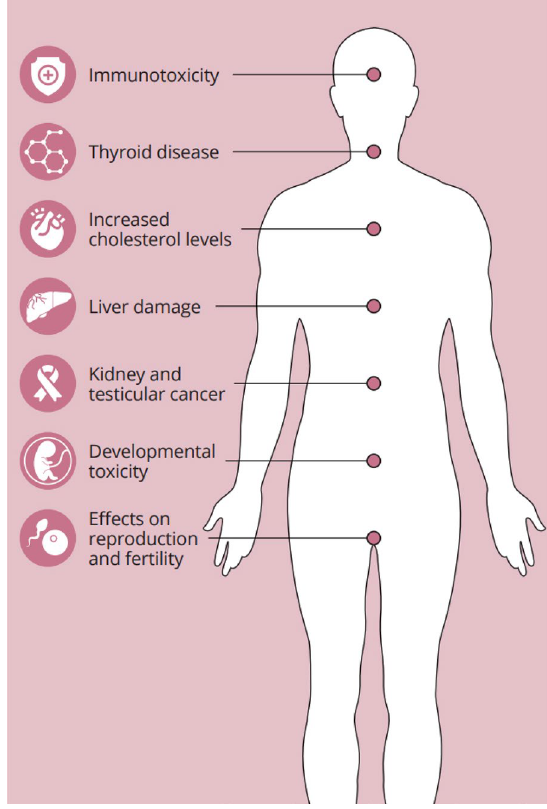
Fig. 2 Illustration of reported effects of PFAS on humans © HBM4EU https:// www. hbm4eu. eu/